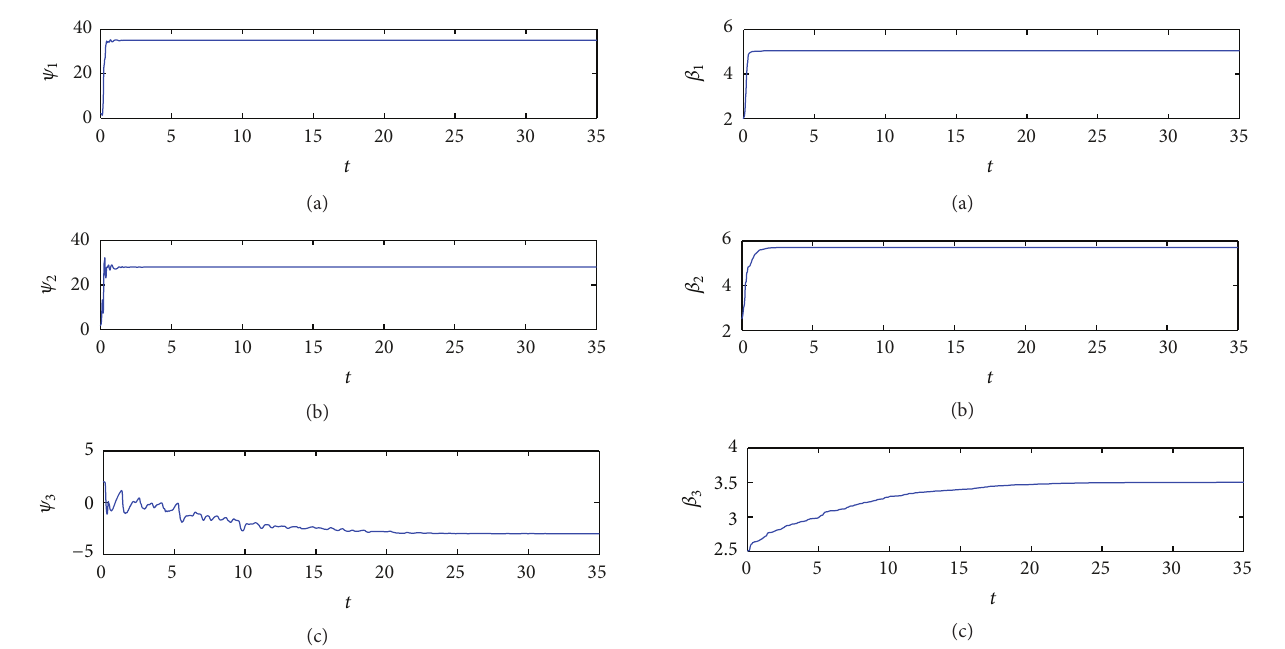
Figure 8: The trajectories of the adaptive laws 𝛽 in Example 1.